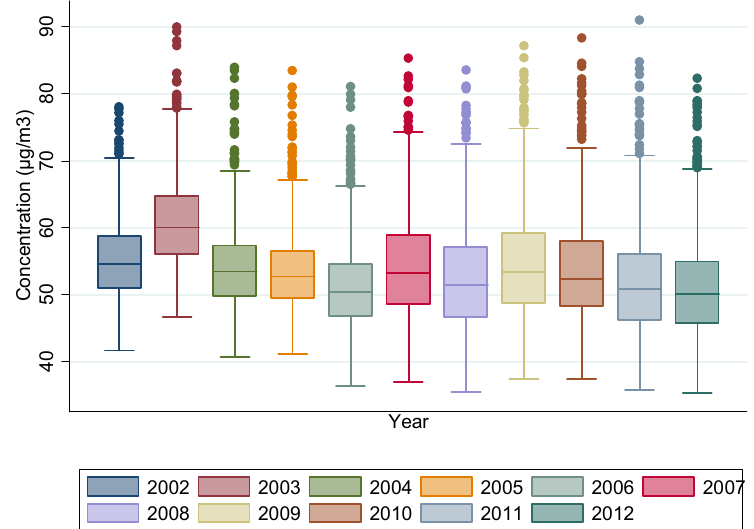
Figure 3. Distribution of NO 2 concentrations at the census block level (in µg/m 3 ) from 2002 to 2012. Box plots (fifth percentile, first quartile, median, third quartile, ninety-fifth percentile).